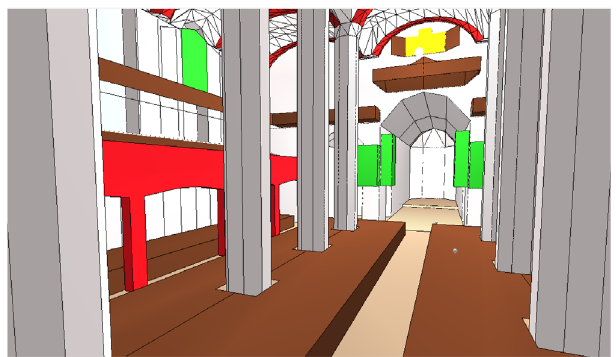
Figure 8. Model of the Thomaskirche in 1723, including second wooden gallery, glass pew enclosures (in green) and the “ swallow ’ s nest ” organ (in